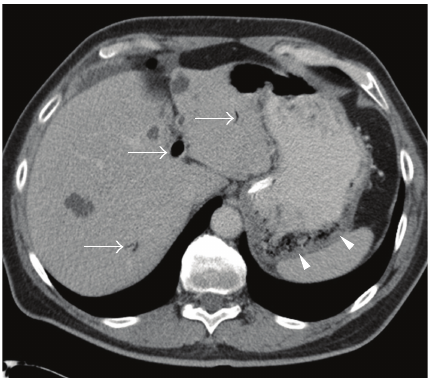
Figure 2: Axial CT scan image demonstrating portal venous gas (arrows) and gastric emphysema (arrowheads). Several benign hep- atic cysts are also visualized.